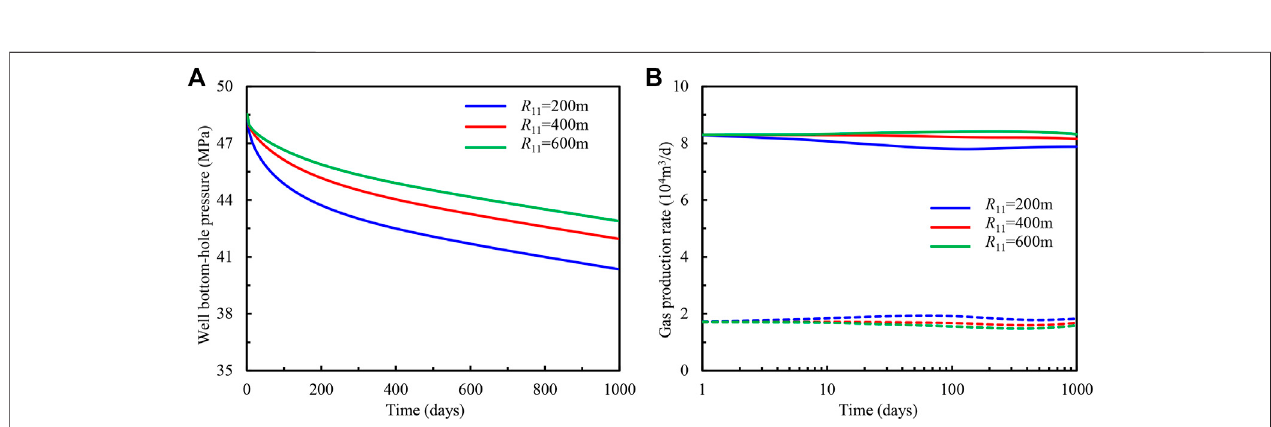
FIGURE 4 | Match for well bottom-hole fl owing pressure with the presented model in (A) Cartesian and (B) Semi-log coordination systems.